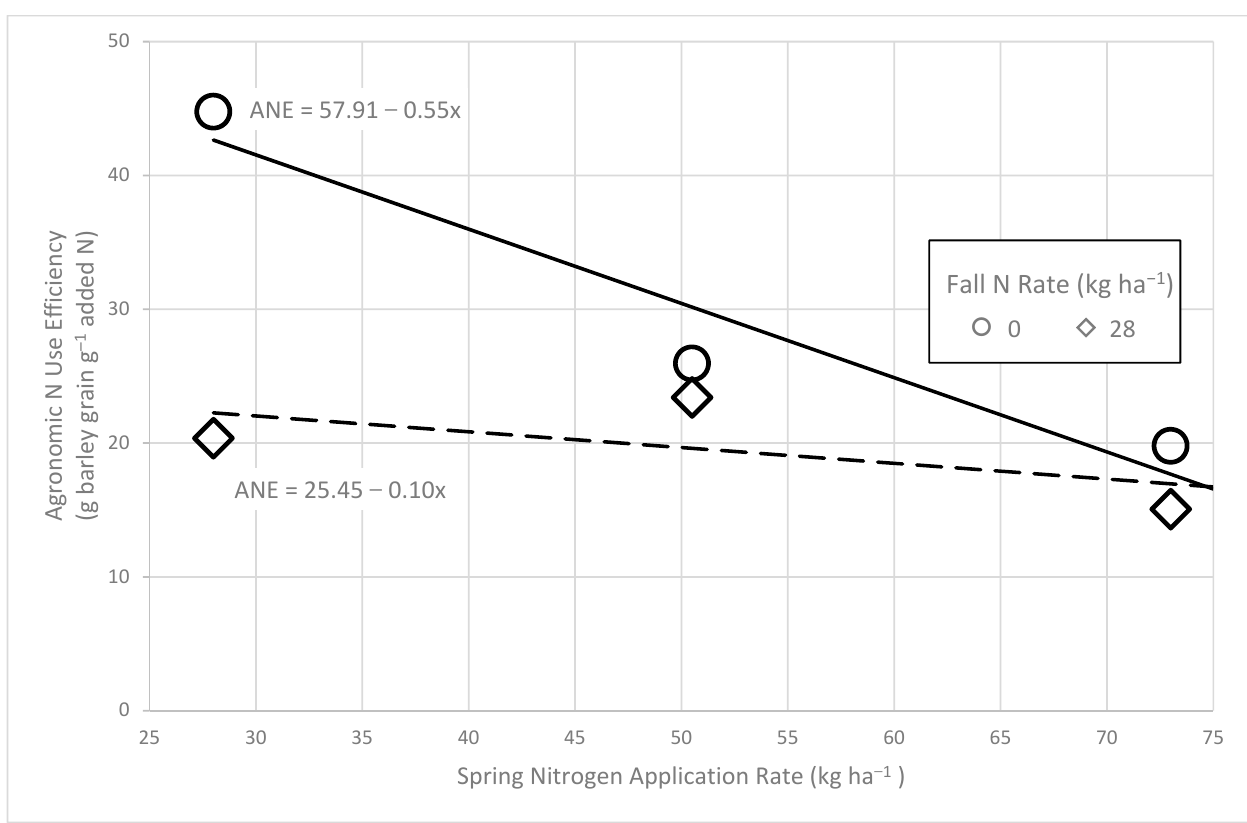
Figure 1. Interactive effect of spring N application with and without fall N application on Agronomic N use efficiency (ANE). Planting date and fall N application significantly interacted to influence winter sur- vival rate. Planting in early September decreased winter survival by 8%, compared with mid or late September plantings (Figure 2). Application of N at the time of planting in the fall intensified the negative influence of early planting on winter survival rate (Figure 3) where stand survival fell from 86% to 78%. However, when planting was delayed, the in- fluence of fall N application on winter survival was less pronounced (Table 2 and Figure 3). The influence of DOP, fall, and spring N application and their interactive effects on winter survival, lodging, foliar disease, and heading time are presented in Table 2. Regard- less of fall N treatment, the difference in heading time and height of plants amongst